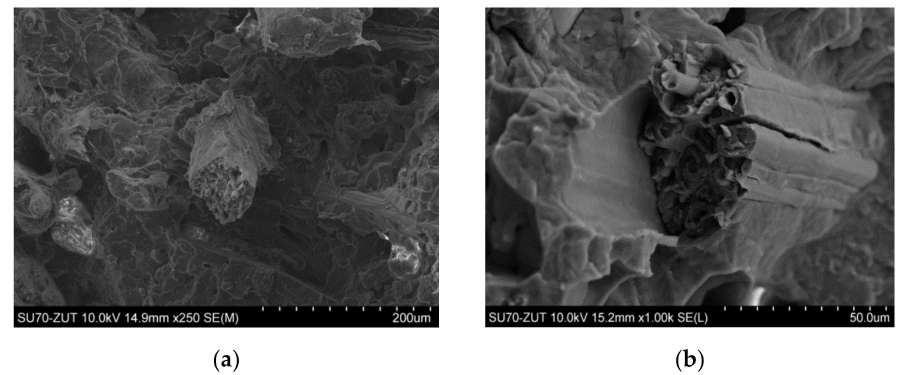
Figure 1. Morphology of PP / kenaf (70 / 30 vol.%) biocomposites at different magnifications ( a ) × 250, ( b ) × 1 k.